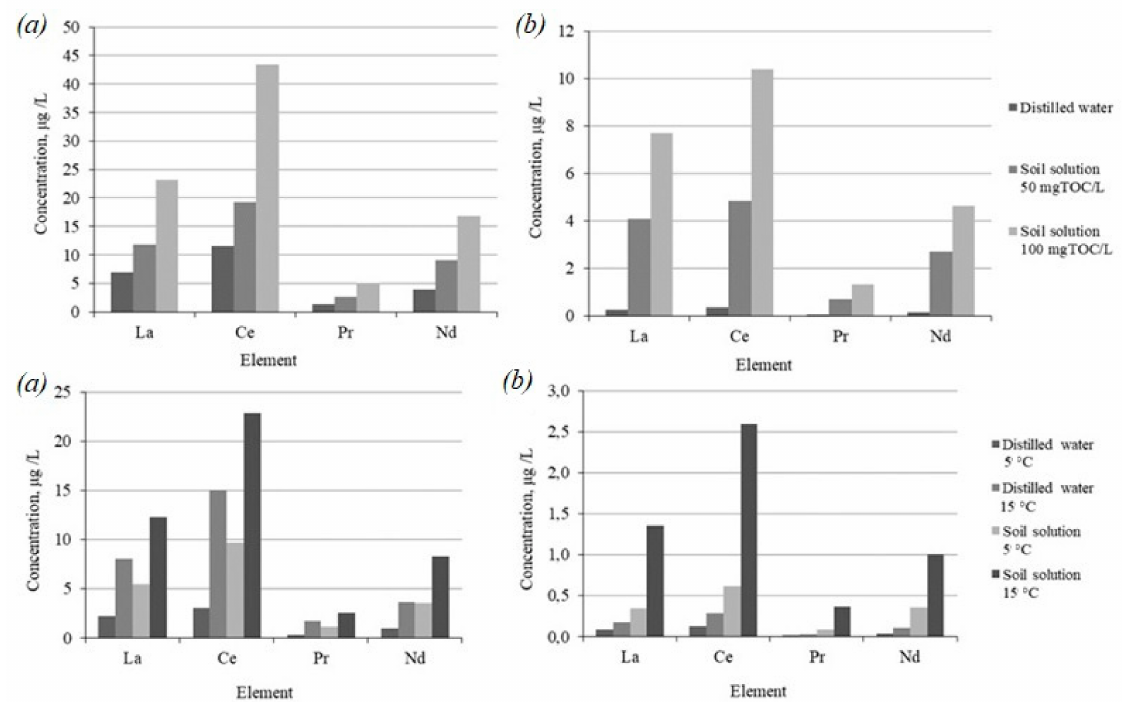
Figure 5. Concentrations of REE in the resulting solutions after five hours of interaction of enrichment tailings of loparite ( a ), apatite-nepheline ( b ) with distilled water and water extracts of